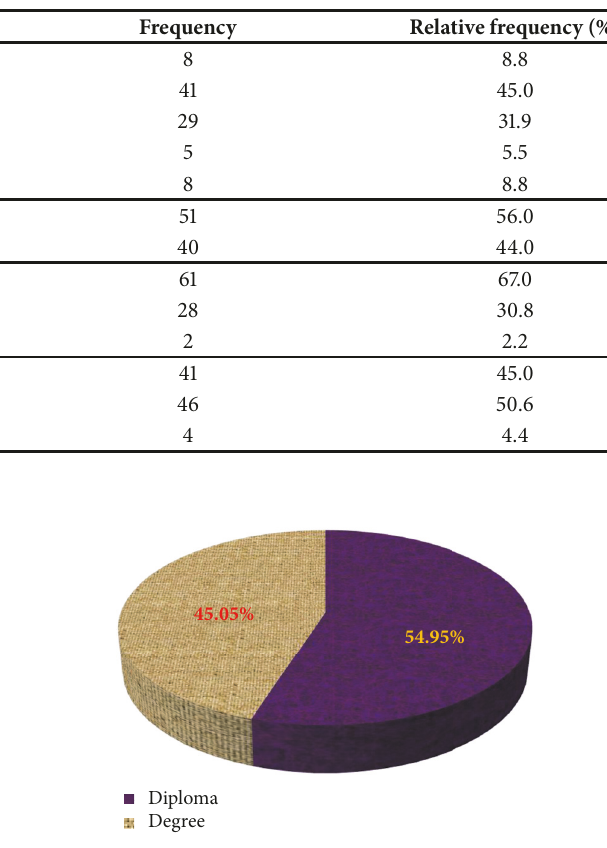
Figure 1: Frequency distribution of study participants by level of education, Dubti Referral Hospital, April